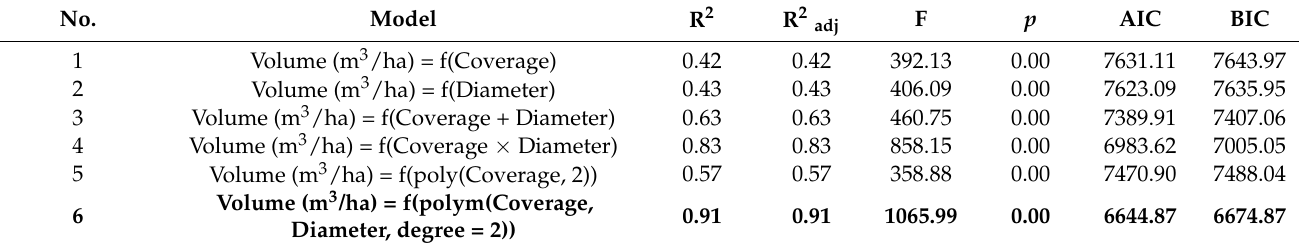
Table 3. Statistical characteristics of models quantifying deadwood volume (m 3 /ha) using a function f(x) with predictors: Coverage represents the proportion of plot area covered by all deadwood pieces if placed next to each other given in %, and Diameter is mean diameter of deadwood pieces in